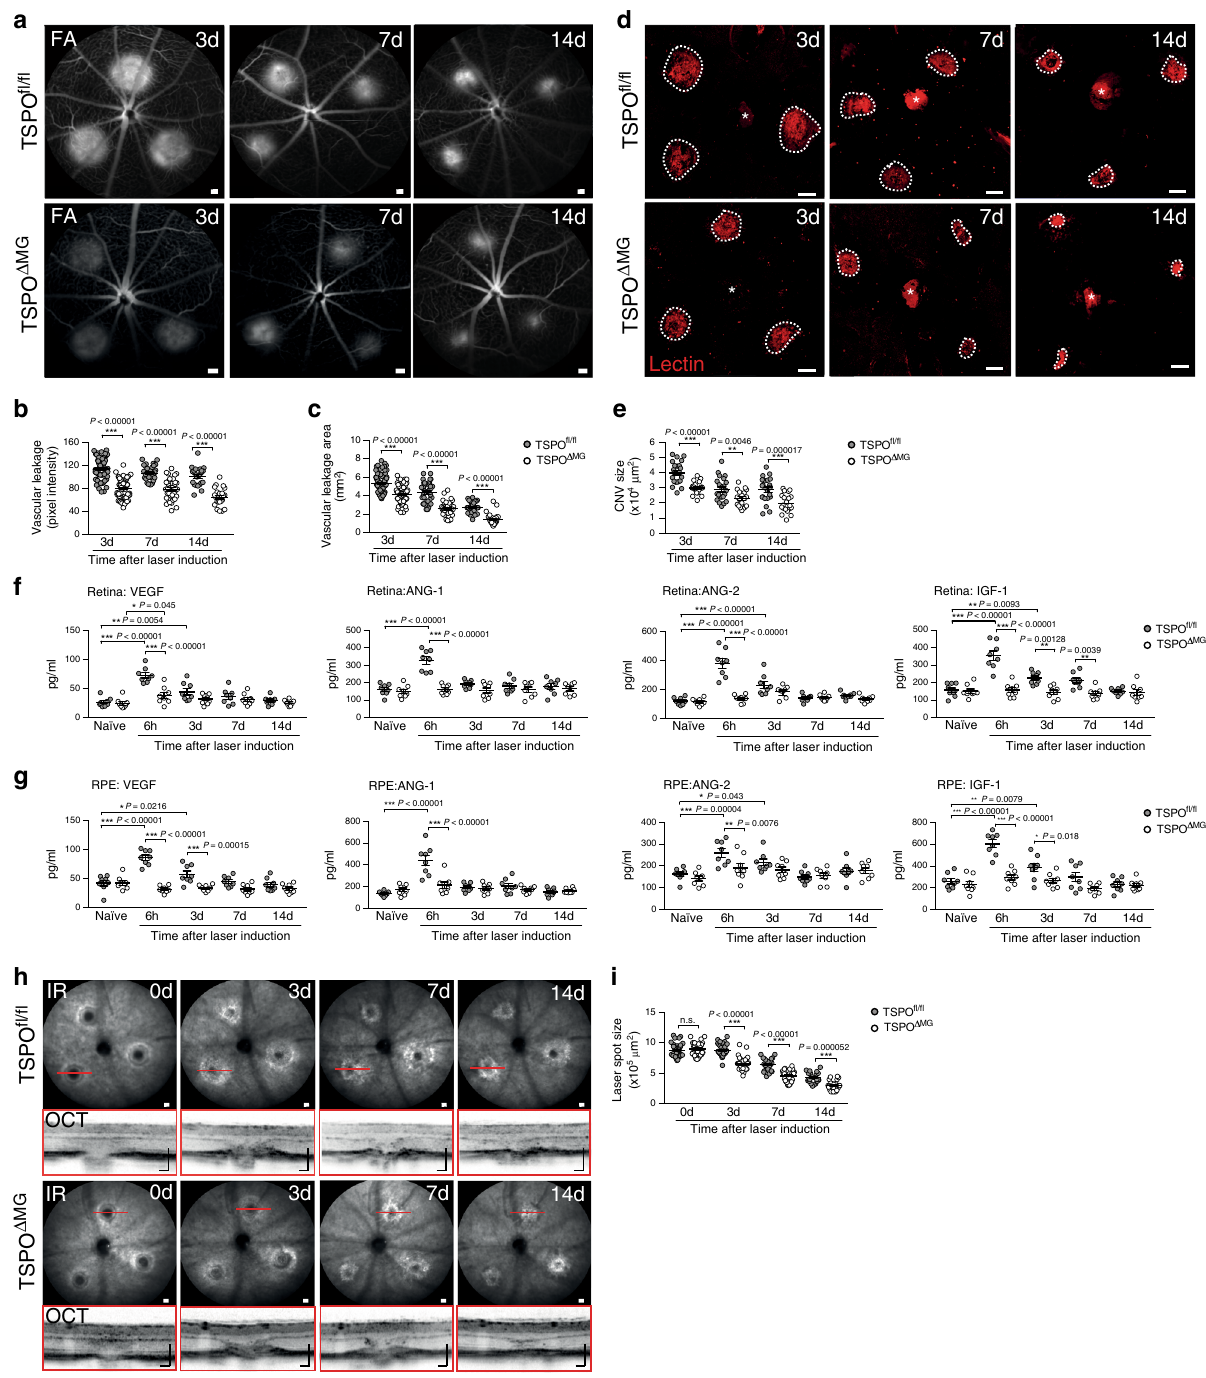
Fig. 4 TSPO de fi ciency inhibits laser-induced vascular leakage and pathological CNV in mice. a Representative late phase fundus fl uorescein angiography (FFA) images at indicated time points post laser injury. Scale bar: 200 µ m. b Quanti fi cation of vascular leakage intensity after laser-induced CNV. 3 d n = 85; 7 d n = 36; and 14 d n = 22 retinas from individual mice. FA fl uorescein angiography. c Quanti fi cation of vascular leakage area after laser- induced CNV. DMSO/XBD173 3 d n = 91/79; 7 d n = 42/33; 14 d n = 30 retinas from individual mice. d Representative laser-induced CNV stained with isolectin B4 in RPE/choroidal fl at mounts. Scale bar: 100 µ m; e Quanti fi cation of laser-induced CNV area in RPE/choroidal fl at mounts. n = 22 RPE/ choroids from individual mice. f Pro-angiogenic growth factor levels in retinas of naïve and lasered TSPO fl / fl and TSPO Δ MG mice at indicated time points. n = 8 retinas/RPEs from individual mice. g Pro-angiogenic growth factor levels in RPE/choroids of naïve and lasered TSPO fl / fl and TSPO Δ MG mice at indicated time points. n = 8 retinas/RPEs from individual mice. h Representative infrared (IR) fundus images at indicated time points post laser injury. Lower panel shows OCT scan from one laser spot marked by a red line. Scale bar: 200 µ m. i Quanti fi cation of laser spot size. 0 d n = 45, 3 d n = 39, 7 d n = 33, and 14 d n = 25 eyes from individual mice. Data show mean ± SEM and a linear mixed model was used for statistical analyses; * P < 0.05; ** P < 0.01; and *** P ≤ 0.001. n.s., not signi fi cant. Source data are provided as a Source Data fi